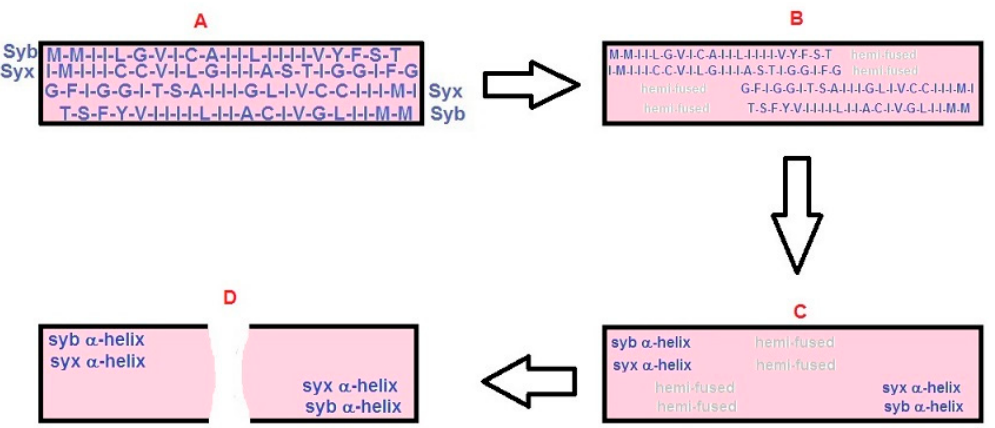
Figure 2. Organization of syb and syx for the short BAT model and the fusion sequence. ( A ) The short BAT model involves the same steps shown in Figure 1A–C, but instead of an end-to-end organization of the inter-membrane domains of syb and syx (as in Figure 1D,E), they reside side-by-side. Shown is a “top” view (that removes the outer hemi-bilayer of the plasma membrane). This is the primed state of the short BAT model ( B ) From the same perspective as in A, this “top” view begins the process that leads to membrane fusion. The inter-membrane segments of syb and syx have begun to retract laterally (denoted by the smaller font size) and this transition from helix leads to hemi-fusion in the areas that had been occupied by protein ( C ) Complete β -to- α transition of the syb and syx inter-membrane regions leads to larger areas of hemi-fusion that culminate in full fusion in ( D ). Possible causes of full fusion are discussed in the text. Color scheme: same as Figure 1.